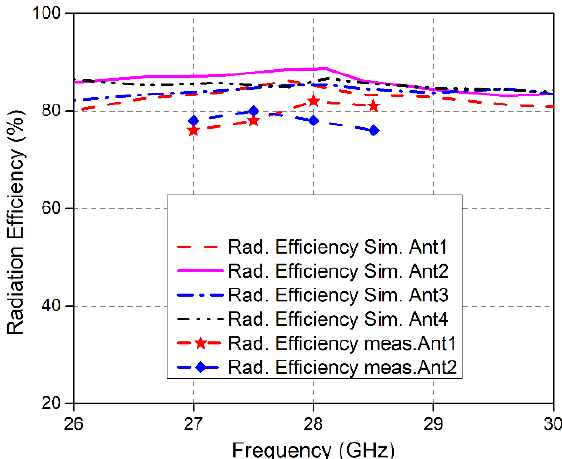
Figure 13. Radiation Efficiency of the proposed MIMO antennas.